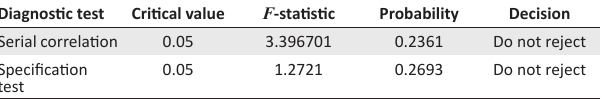
TABLE 5: Postestimation diagnostic tests.